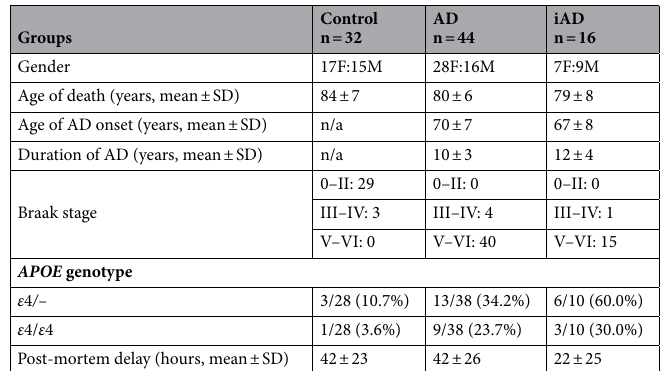
Table 5. Demographic, clinical and post-mortem characteristics of the three groups. Control neurologically/ cognitively normal controls, AD Alzheimer’s disease cases, iAD immunised Alzheimer’s disease cases F female, M male, APOE genotyping was not available for all cases n/a not-applicable, S D standard deviation.